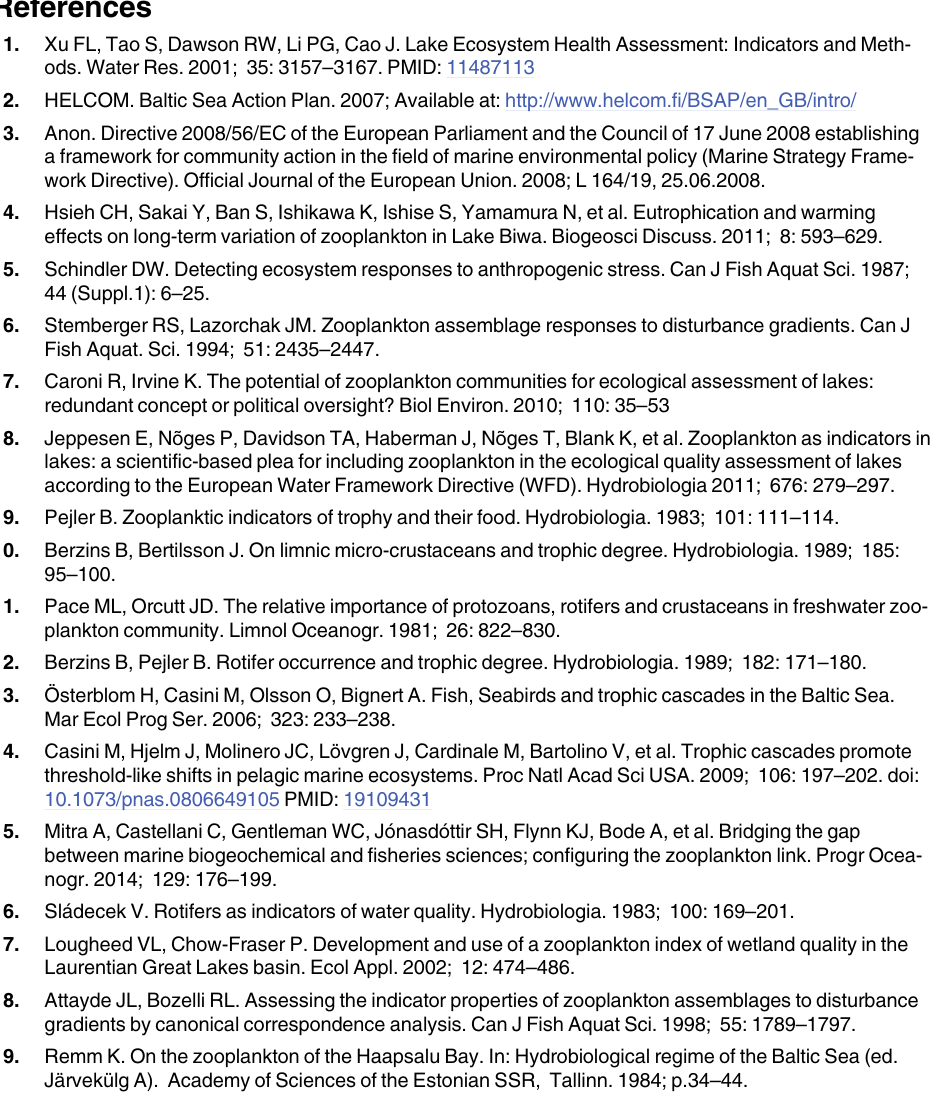
S1 Table. Details for zooplankton sampling and analysis methods employed in the national laboratories. S2 Table. Pearson r correlations among the indicators in each dataset. Significant correla- tions at p < 0.05 are in bold; n – number of samples (i.e., the number of years included in the dataset). See Tables 1 and 2 for indicator and dataset